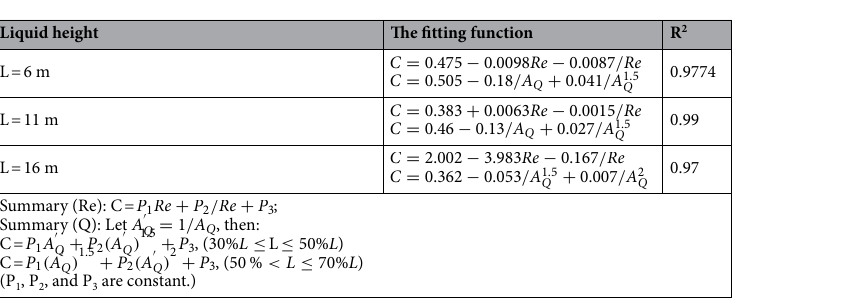
Figure 9. Variation of C with Re and A Q in the height range of the control area. Liquid height The fitting